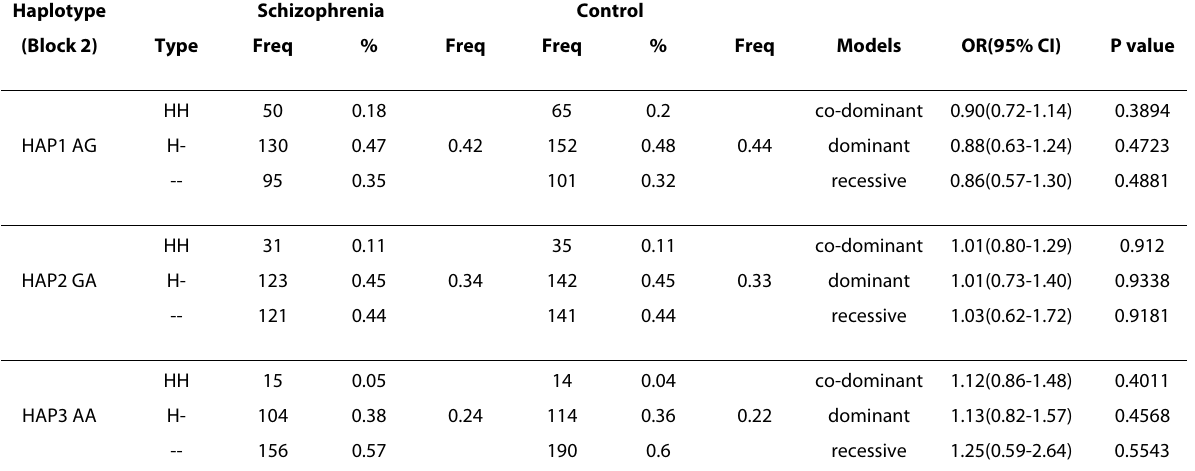
Table 3: WNT2 SNPs haplotype frequencies in schizophrenia patients and healthy controls. Haplotype